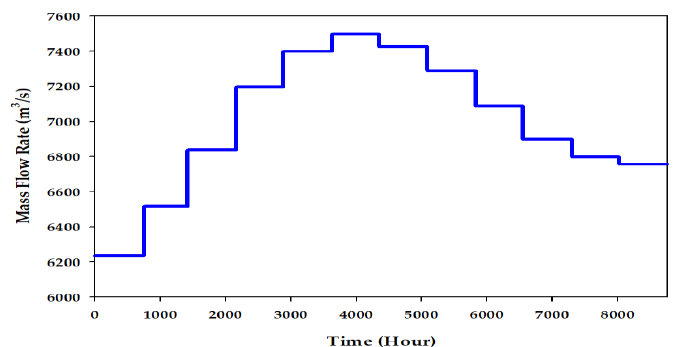
Figure 5. Mass flow rate. Figure 5. Mass flow